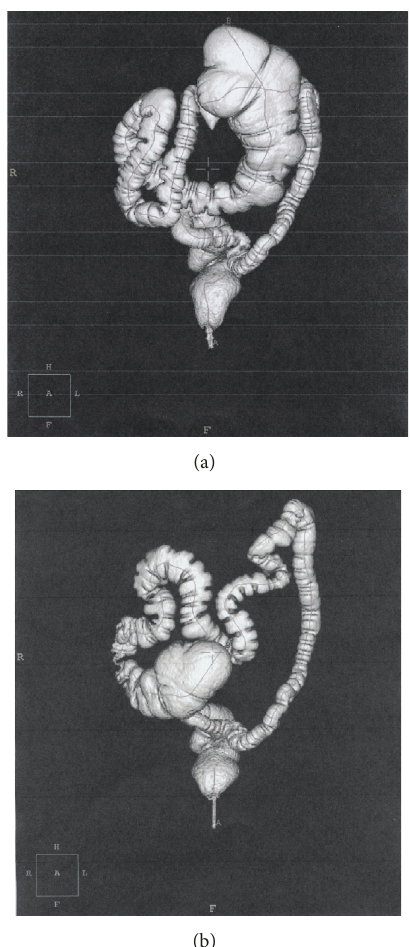
Figure 3: (a) Virtual colonoscopy. Three-dimensional volume- rendered CT colonography (anteroposterior view) showed an elon- gated right colon with the cecum dislocated in the upper left quadrant. (b) Virtual colonoscopy one year after surgery. Three- dimensional volume-rendered CT colonography (anteroposterior view) demonstrated the cecum and the ascending colon in the physiological